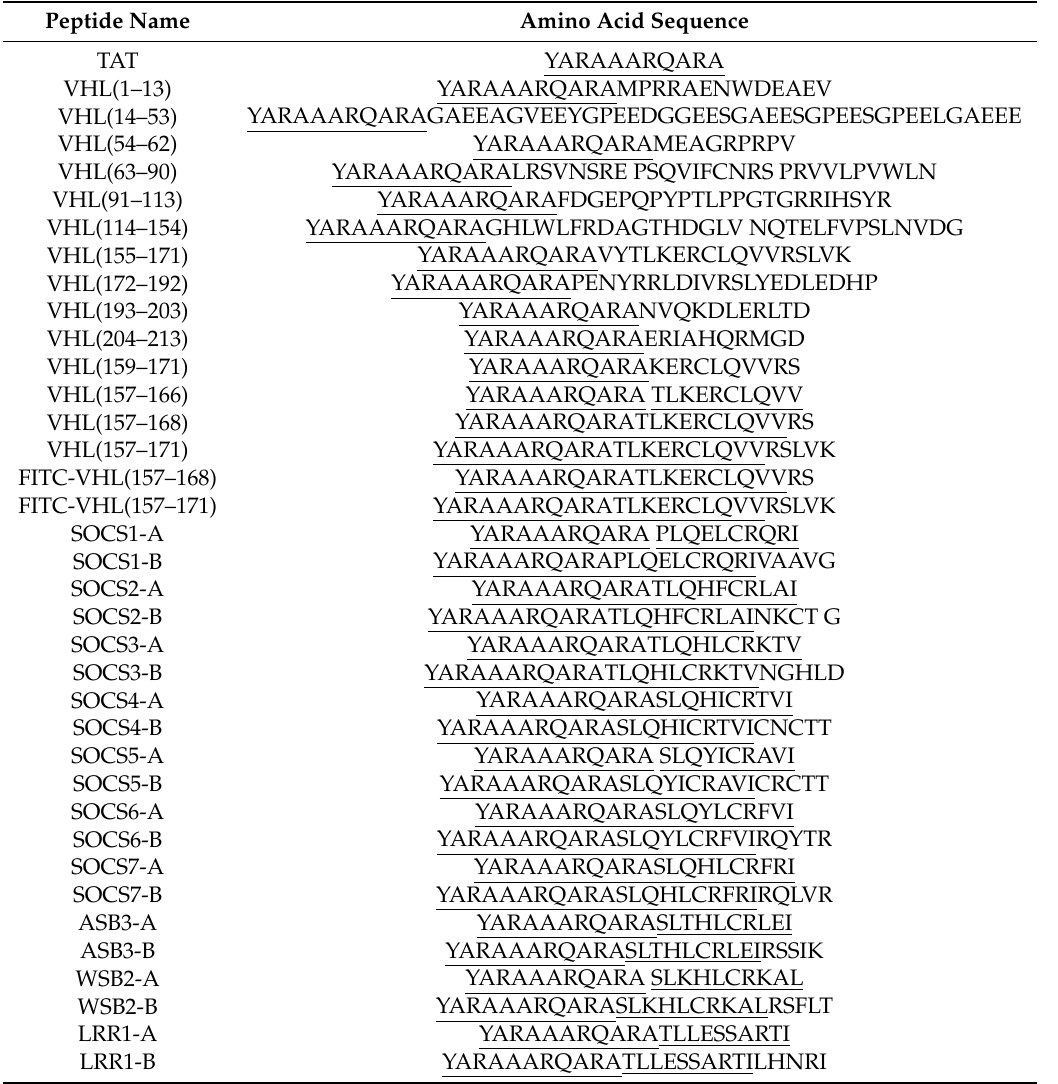
Table 1. List of synthetic